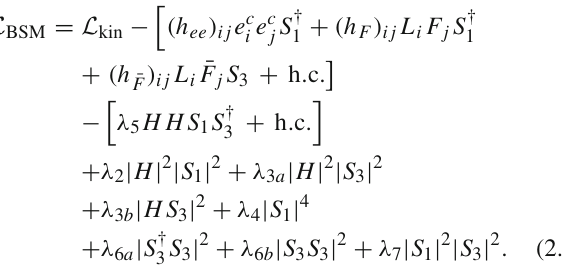
were absent, lepton number would be conserved and if both ¯ ¯ F i → e − i θ F i , becomes exact. Therefore try, F i → e i θ F i ,